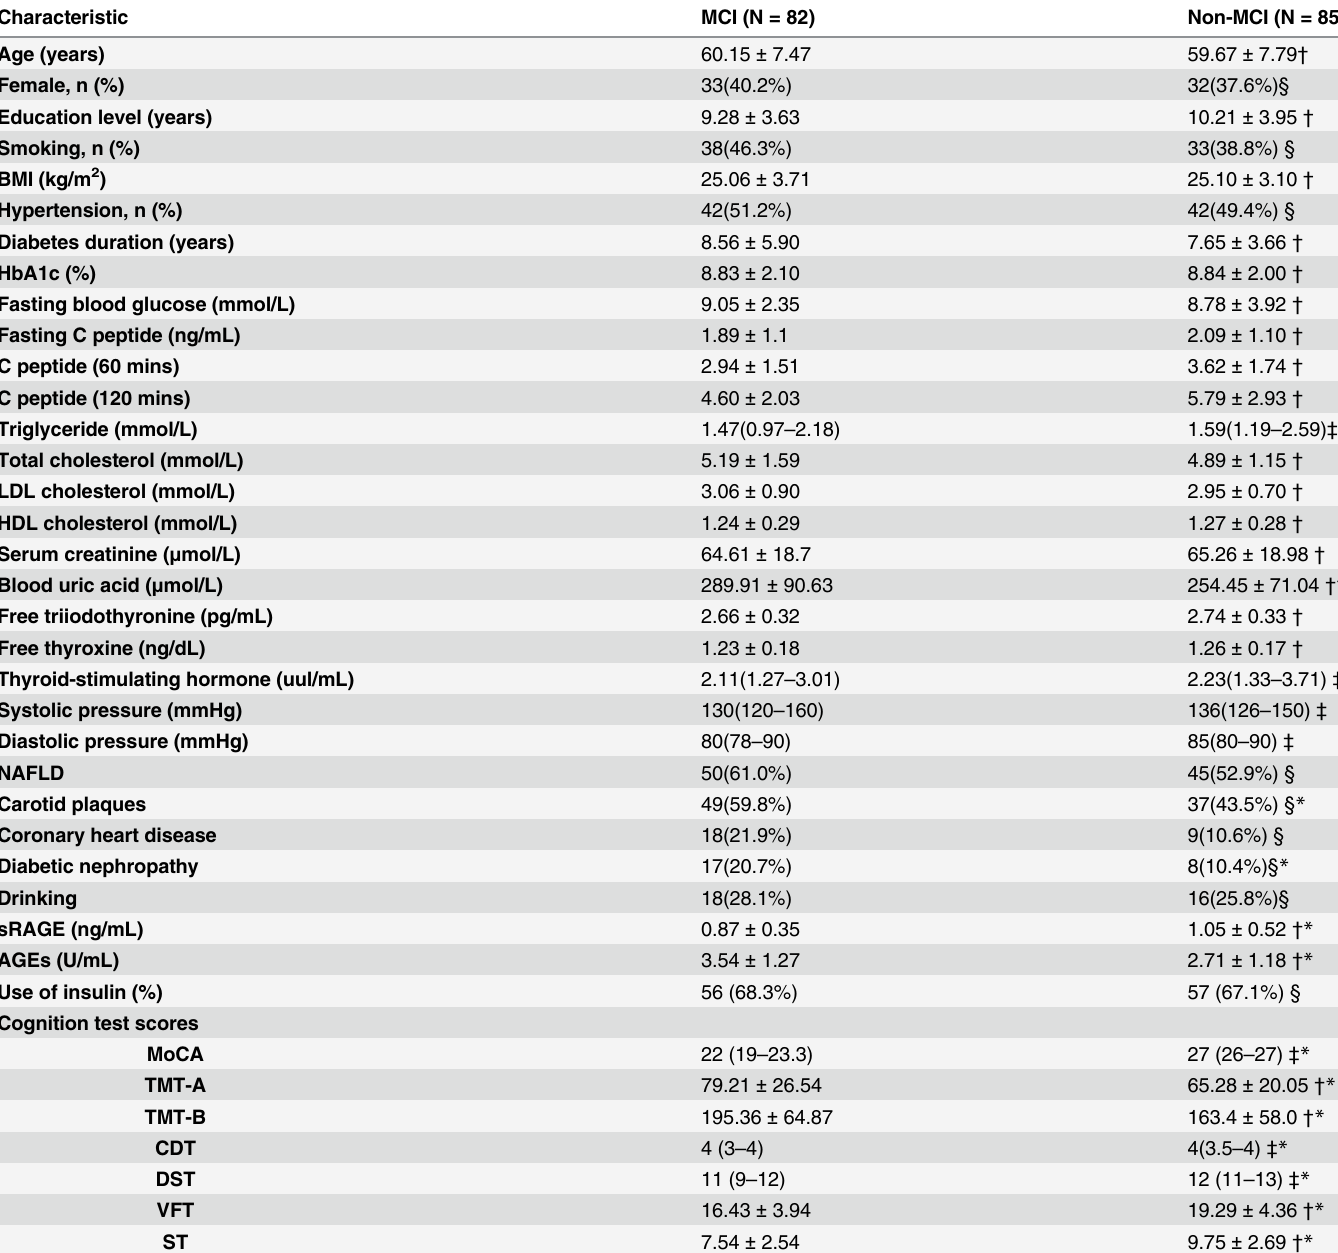
Table 1. Demographic, clinical and cognitive